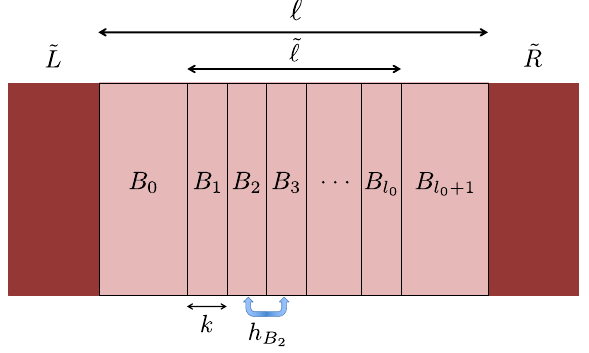
FIG. 7. The decomposition of the subset S into